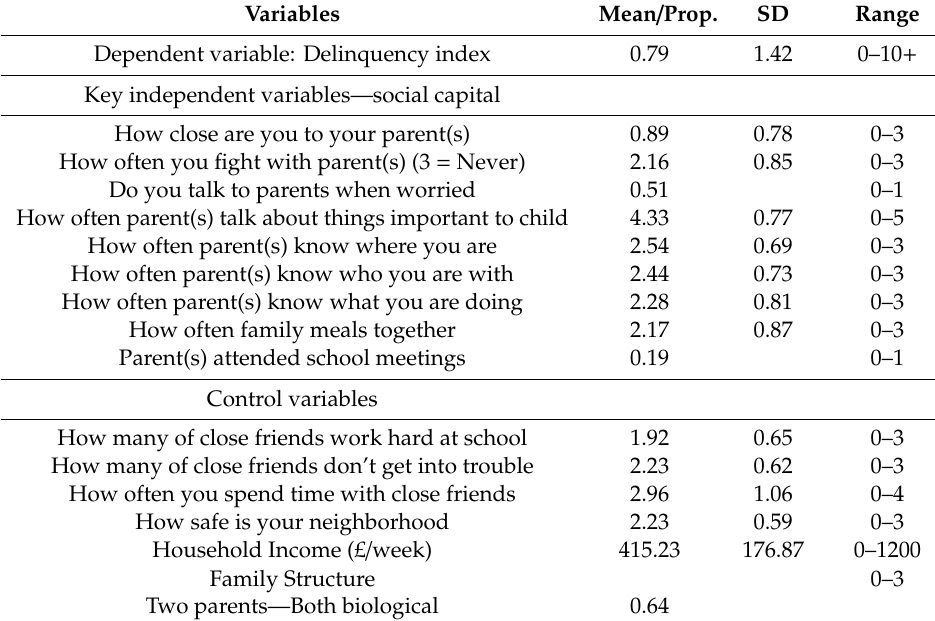
Table 1. Descriptive Statistics for Analytic Sample; n =